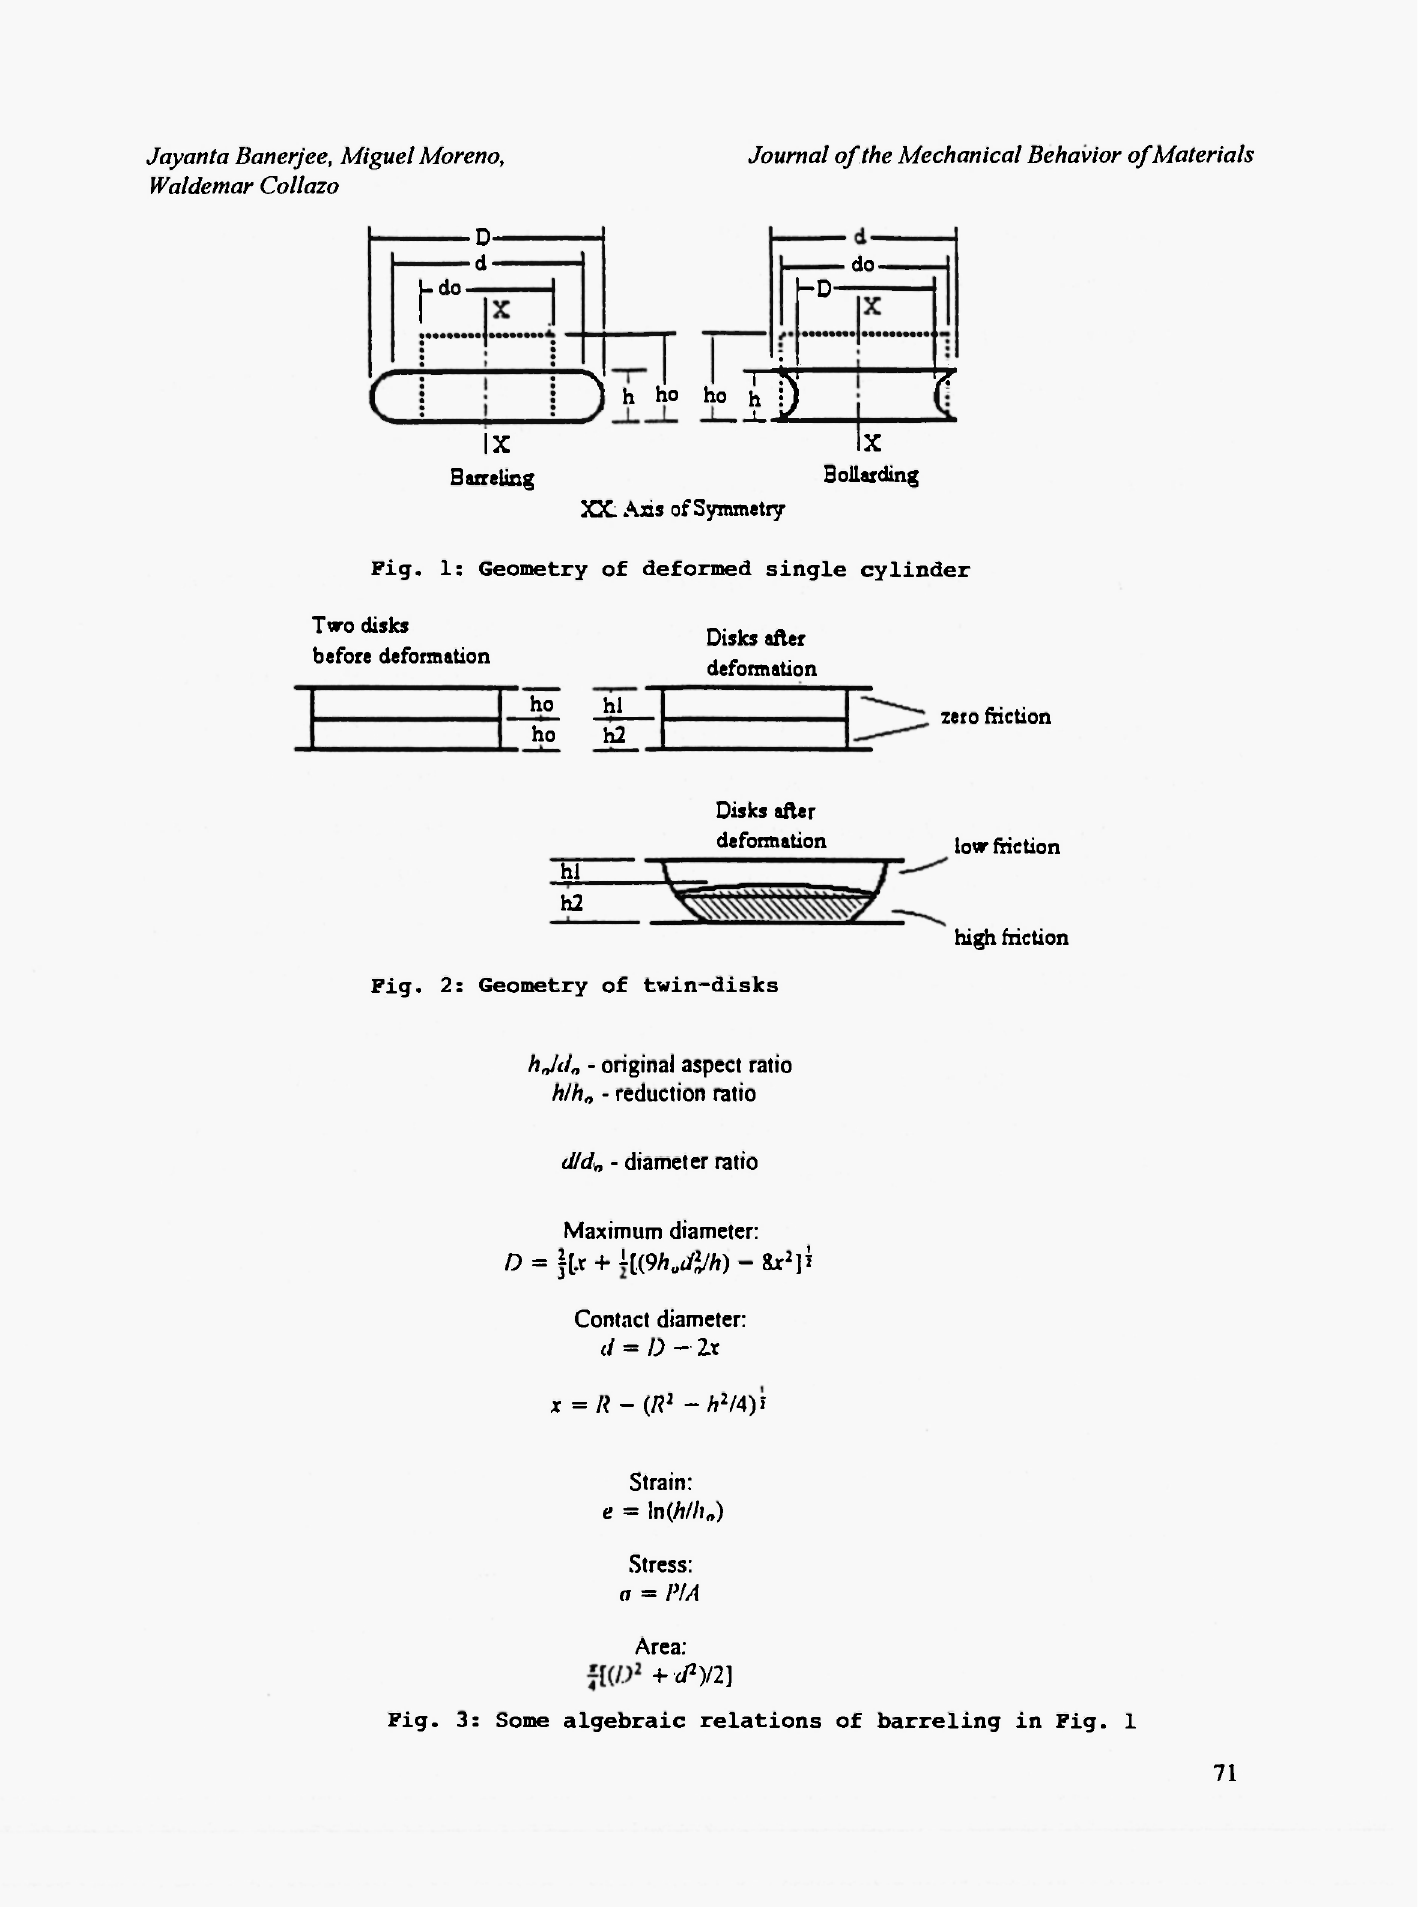
Fig. 3: Some algebraic relations of barreling in Fig.